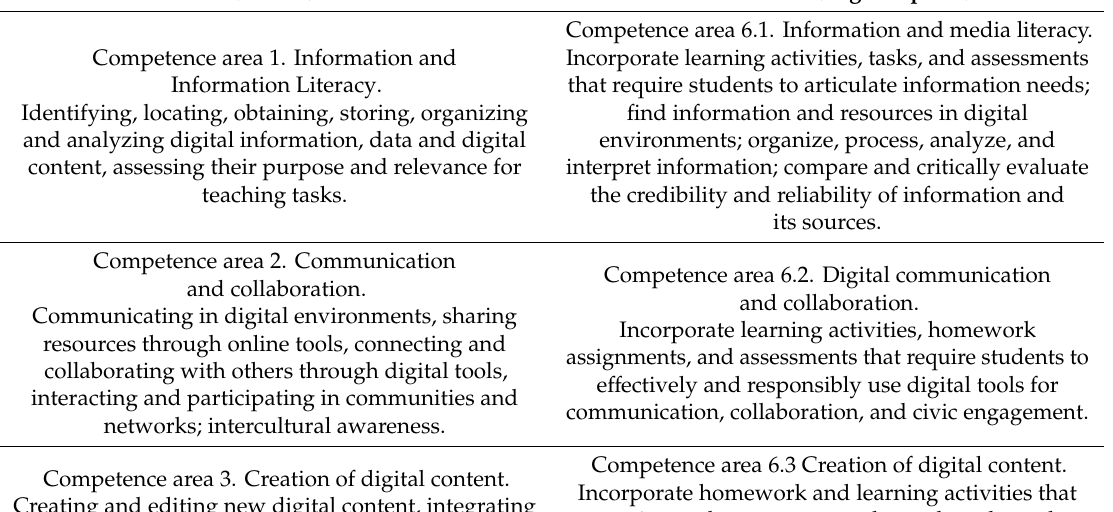
Table 1. Integration of competence areas between the Common Framework for Digital Competence (INTEF) and the European Framework for the Digital Competence of Educators (DigCompEdu) / Competence Area 6 (Facilitating Students’ Digital Competence) for the development and acquisition of digital competences in a complete teaching–learning process. Common Framework for Digital Competence European Framework for the Digital Competence of Educators